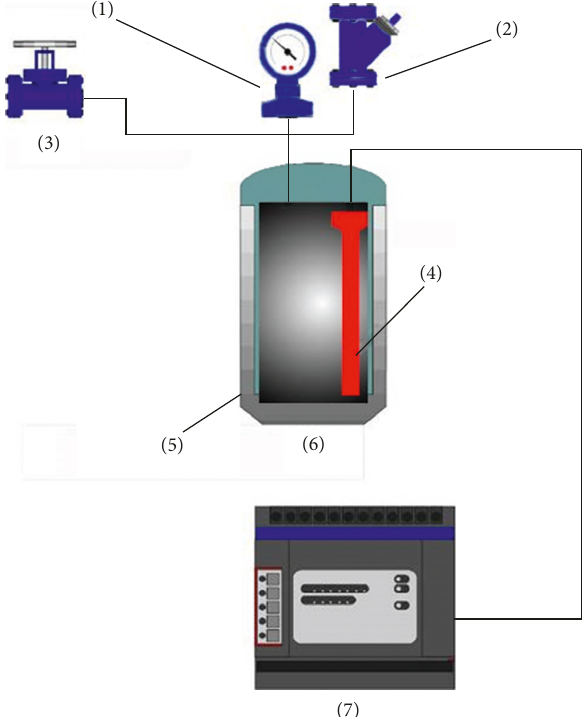
Figure 1: Experimental schematic diagram of the subcritical water system for crude polysaccharide production from okara. (1) Pressure gauge, (2) safety head, (3) pressure release valve, (4) temperature sensor, (5) insulation jacket, (6) SWTreactor, and (7) temperature controller and